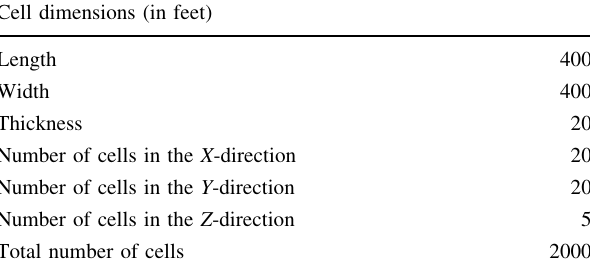
Table 2 Summary of grid data used in static modeling